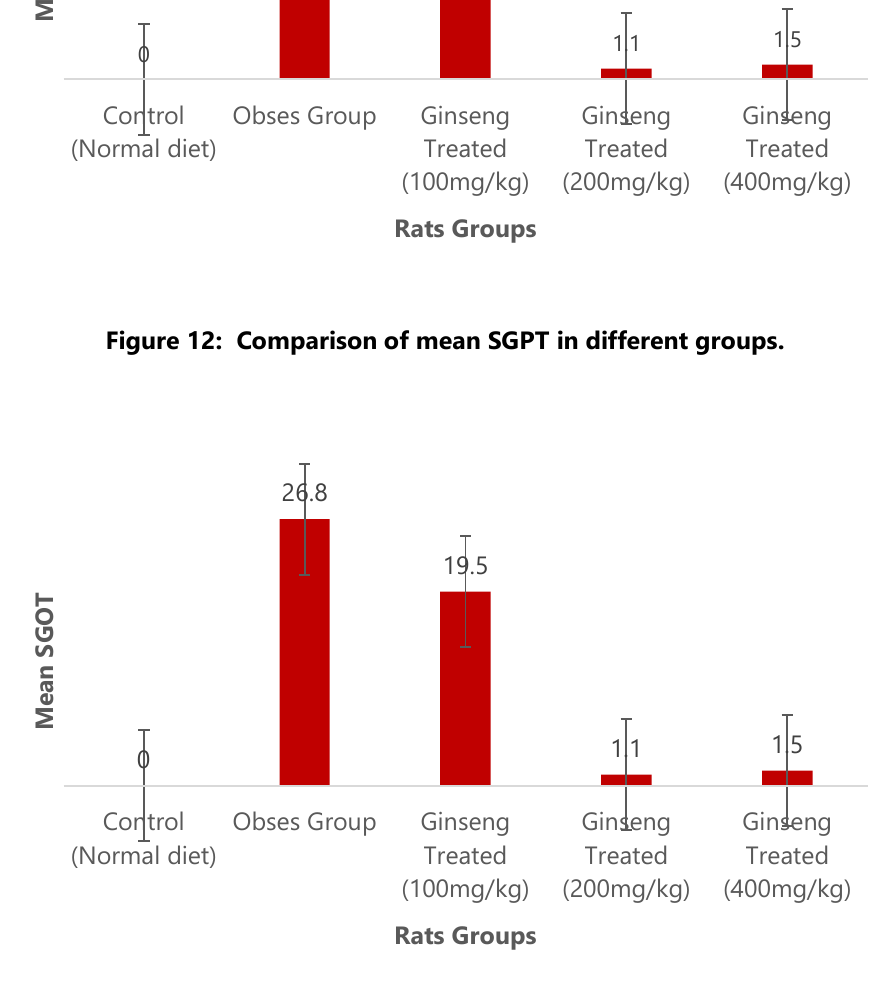
Figure 13: Comparison of mean SGOT in different